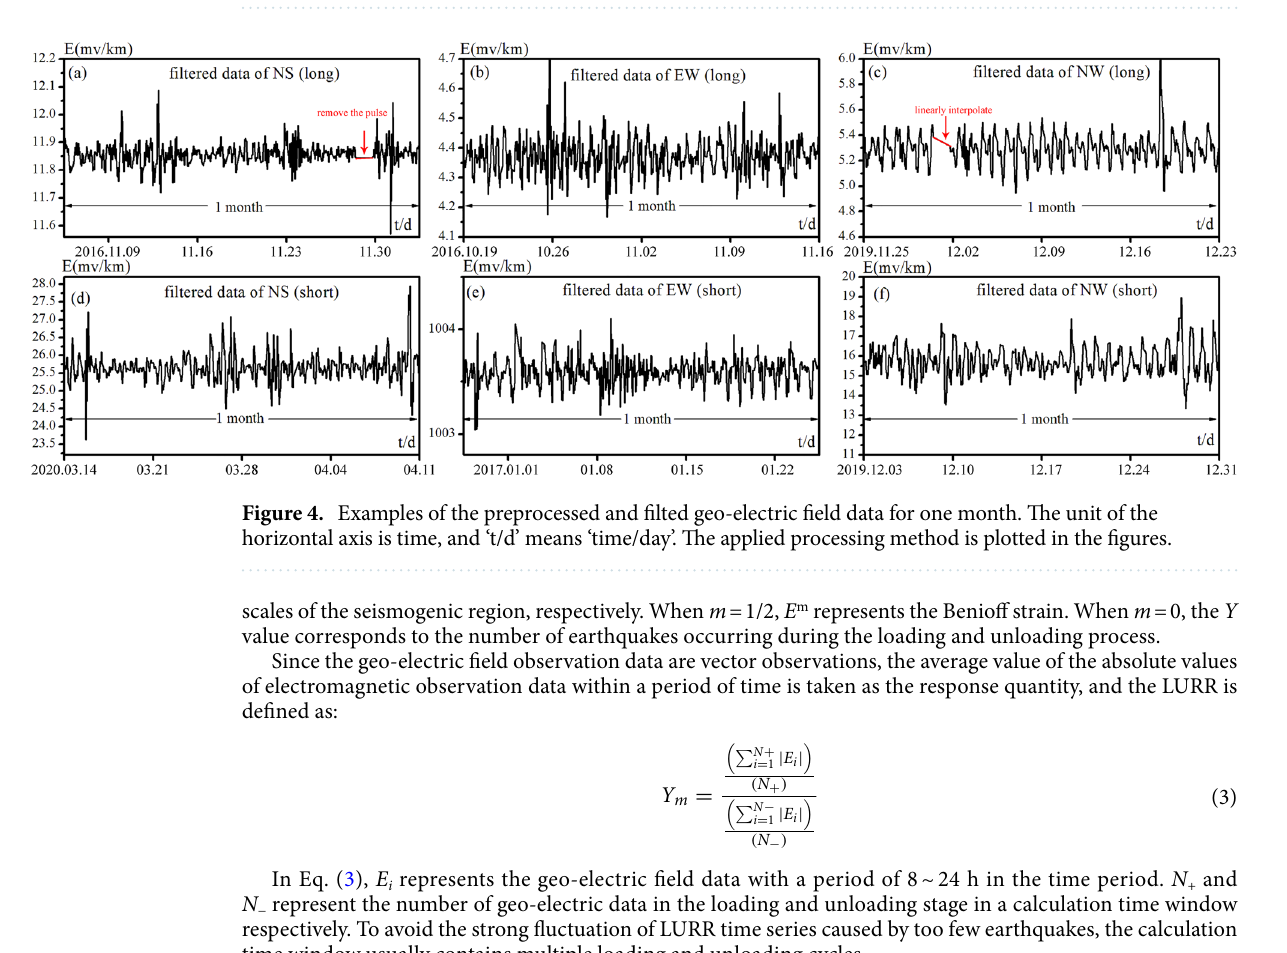
Figure 3. Raw data of geo-electric field for LURR calculation, with the time of earthquake in each of the maps indicated by the red vertical arrows.